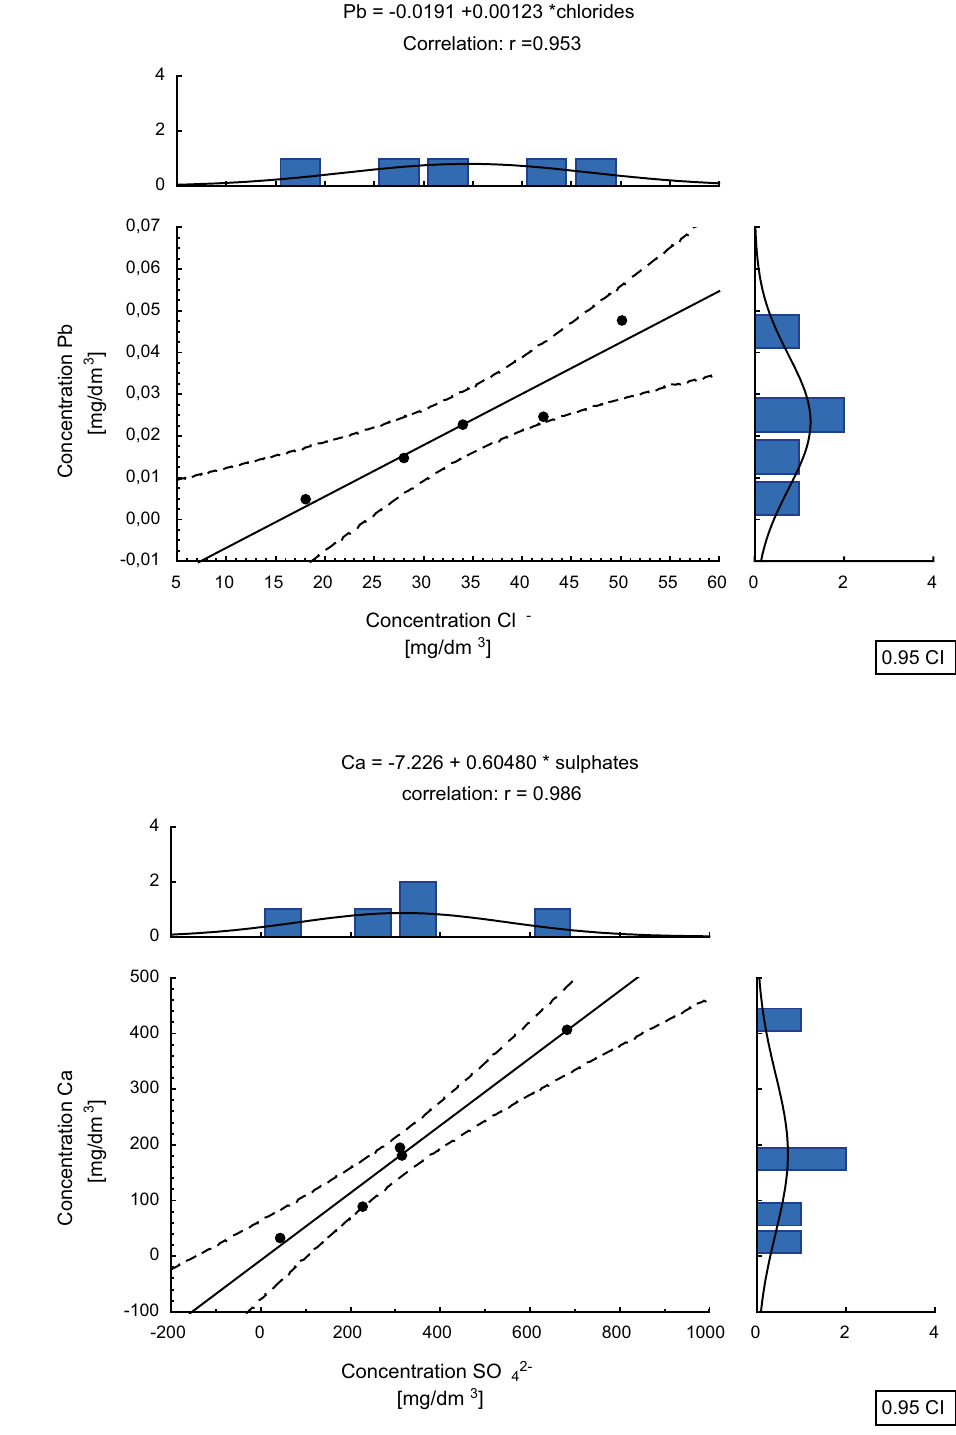
Pb = -0.0191 +0.00123 *chlorides Correlation: r =0.953